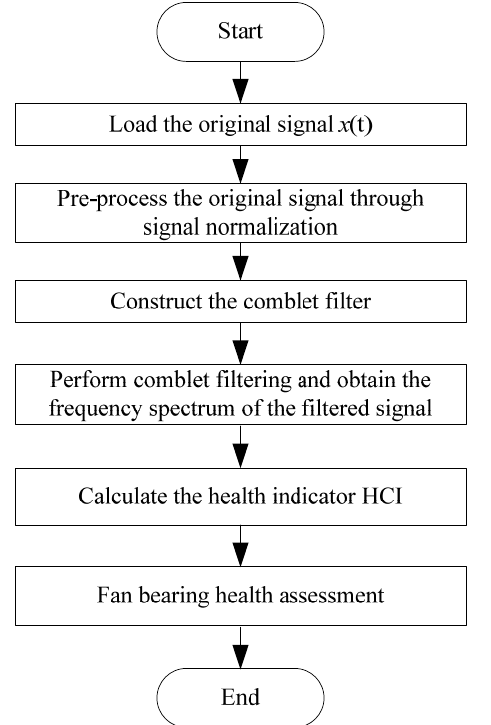
Figure 5. Flow chart of the proposed cooling fan bearing health assessment